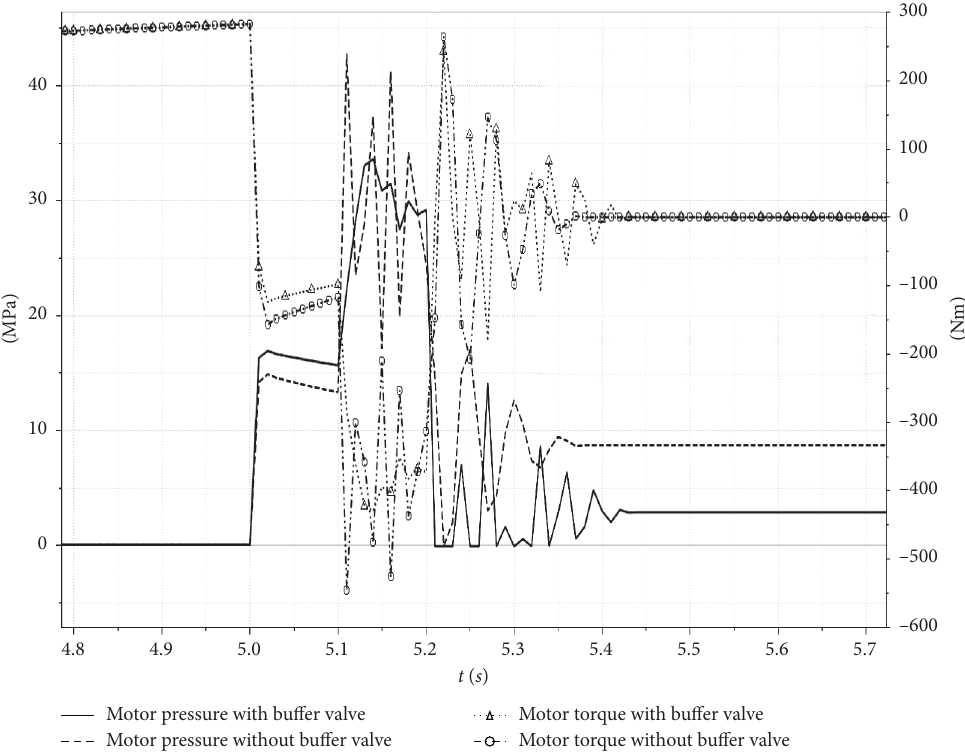
Figure 5: Motor pressure-torque comparison curve with or without buffer filling oil valve set.